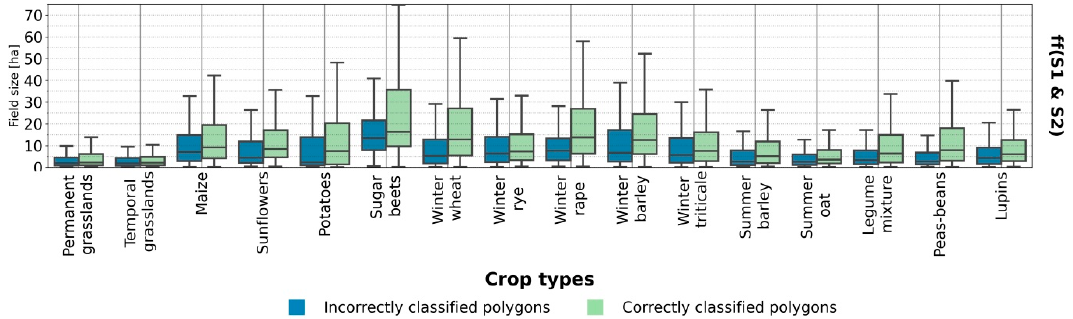
Figure 13. The parcel size distribution of misclassified and correctly classified pixels for ff(S1&S2) . The plots for S1 , S2 , and df(S1&S2) can be found in Supplementary Materials D.